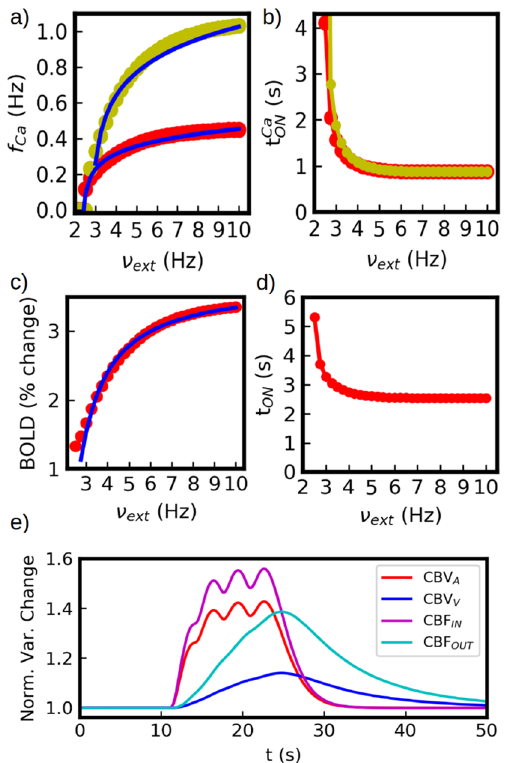
Figure 8. ( a ) Calcium spike frequency as a function of the external neuronal (excitatory) firing rate. We show the results for two different set of parameters. In red, the same parameters used for the rest of the paper. In green, parameters leading to a shorter calcium refractory period and higher maximum frequency rate. These results correspond to O 2 = 0.2 x 10 3 (mMs) − 1 (red) and O 2 = 0.2 x 10 4 (mMs) − 1 (green) in Eq. (5). The rest of the parameters remain unchanged (see Tables 1 and 2 in the Supp. Inf.). We see that the rate increases by a factor larger than two between the two set of parameters. For both cases we show a fit with a logarithmic function (solid blue line), as explained in Section “Calcium coding and BOLD response”. ( b ) Calcium response onset time (t Ca ON ) as a function of external excitatory firing rate. We see that the time increases rapidly near the threshold for calcium activation, but then it quickly converges to a value close to 1 s. ( c ) Amplitude of the BOLD response as a function of the external excitatory rate (red). We show a fit on the response with a phenomenological expression used in experimental results 49 (solid blue line, see main-text). ( d ) Onset time of the BOLD response. In agreement with panel ( b ) we see that the time increases rapidly close the threshold for calcium activation and then it quickly converges to a value close to 2 s. ( e ) Dynamics of the vascular response during external stimulation. We show the normalized variable change (Norm. Var. Change) of the Cerebral Blood Volume at the arteriole (CBV A ) and venule level (CBV V ), together with the incoming and outgoing blood flow (CBF IN , CBF OUT